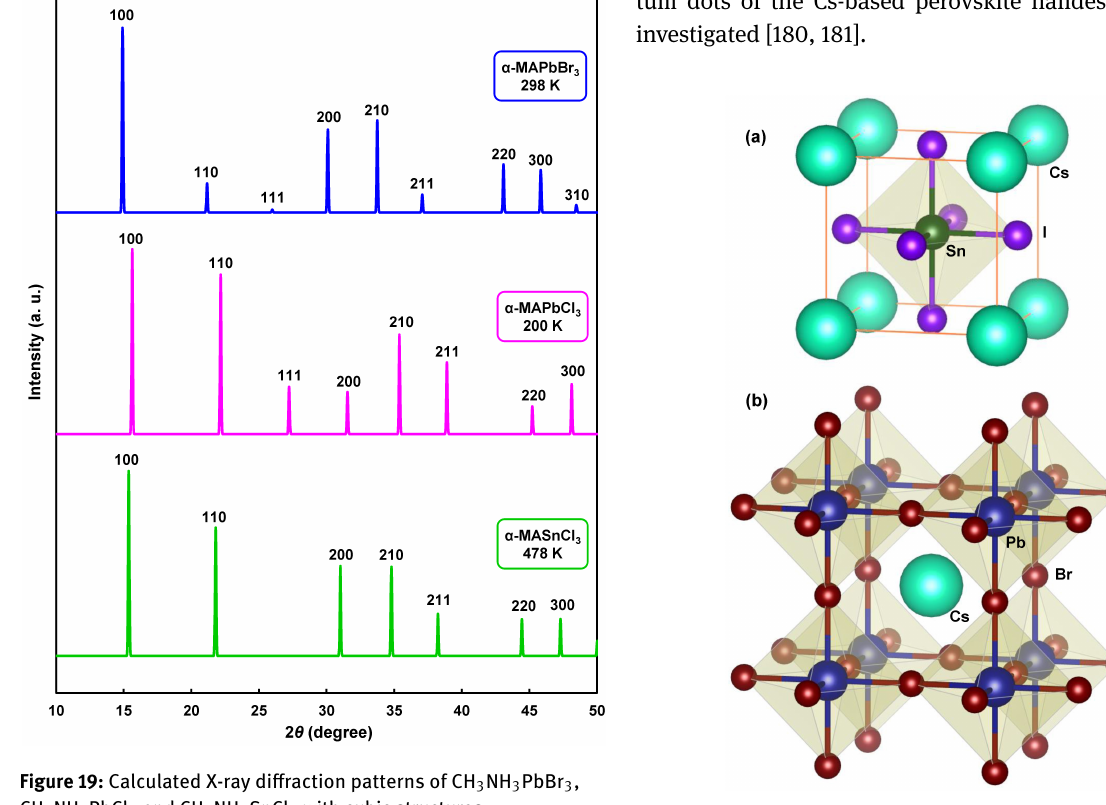
Figure 20: Structural models of (a) CsSnI 3 and (b) CsPbBr 3